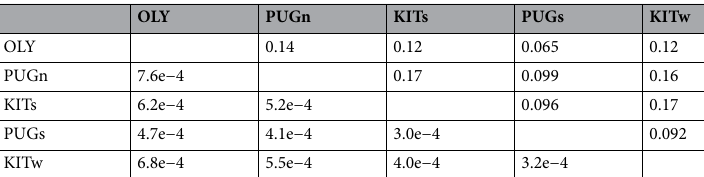
Table 3. F ST values between genetic groups (upper diagonal) and pairwise distances (lower diagonal) for Sceloporus occidentalis in the Puget Sound region. The lowest pairwise distance between any two samples from a given population is shown, rather than an average of all samples from a given locality. The five groups comprising the Puget Sound region are: OLY Olympic Peninsula, KITs Kitsap Peninsula south, KITw Kitsap Peninsula west, PUGn Puget Sound north, and PUGs Puget Sound south.